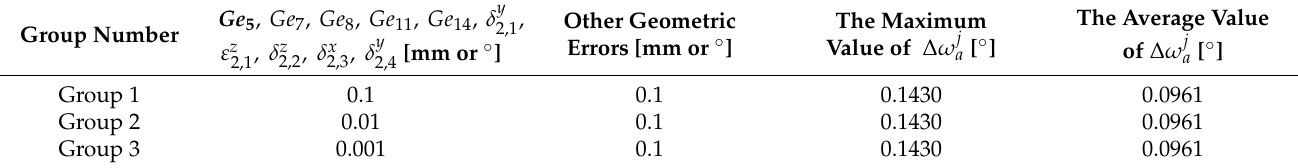
Table 9. Sensitivity analysis results of the average angular comprehensive deformation.